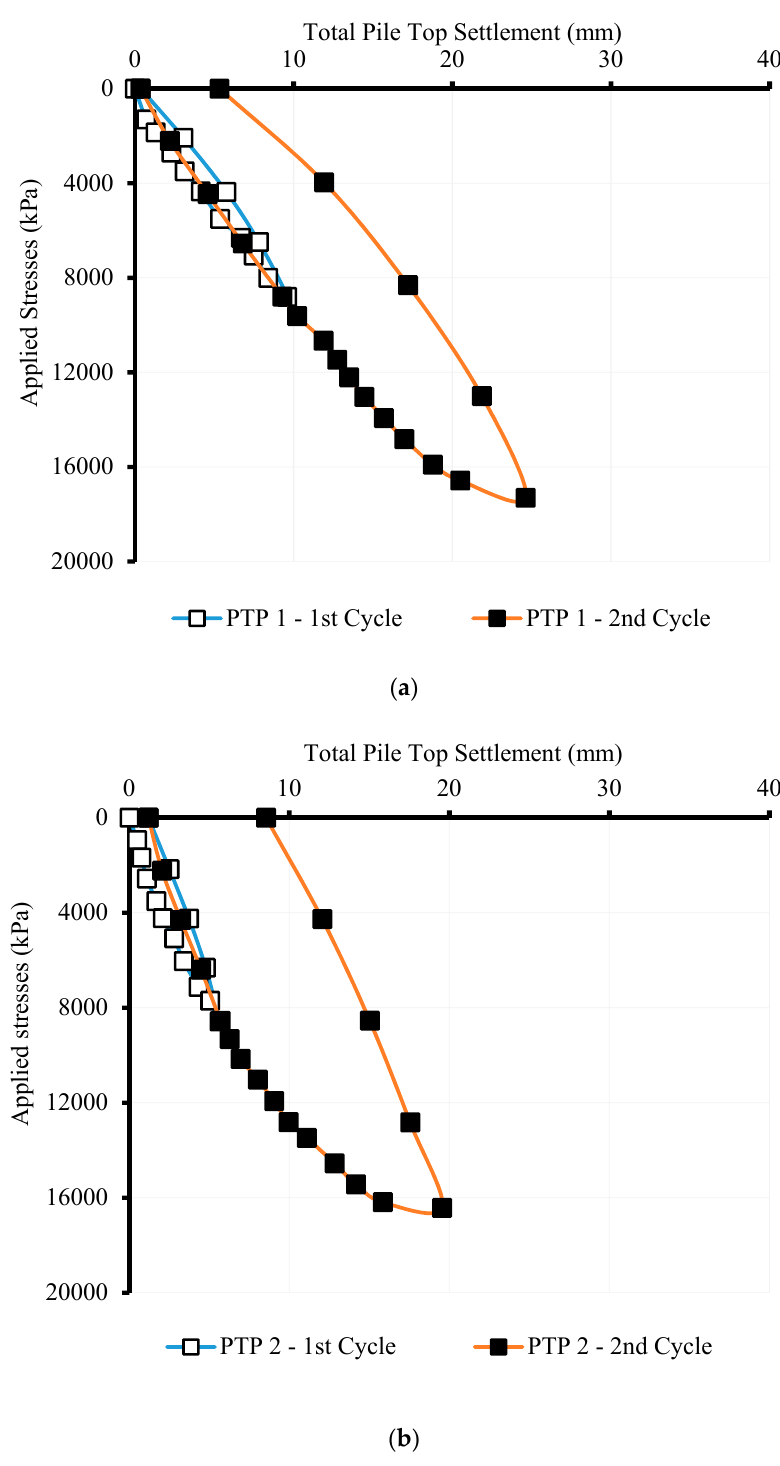
Figure 18. Different applied stresses versus total pile top settlement in ( a ) BP# 1 and ( b ) BP# 2.